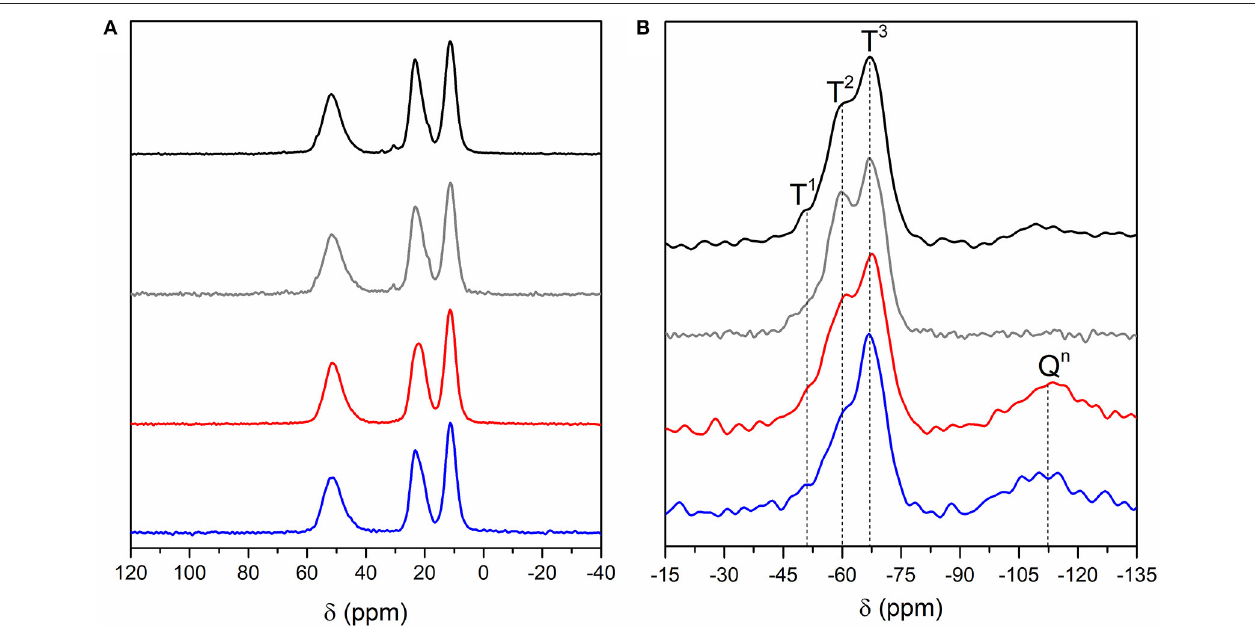
FIGURE 2 | 13 C CP/MAS (A) and 29 Si MAS (B) NMR spectra of the BS-1 (black line), BS-2 (gray line), BS-3 (red line), and BS-4 (blue line) hybrids.